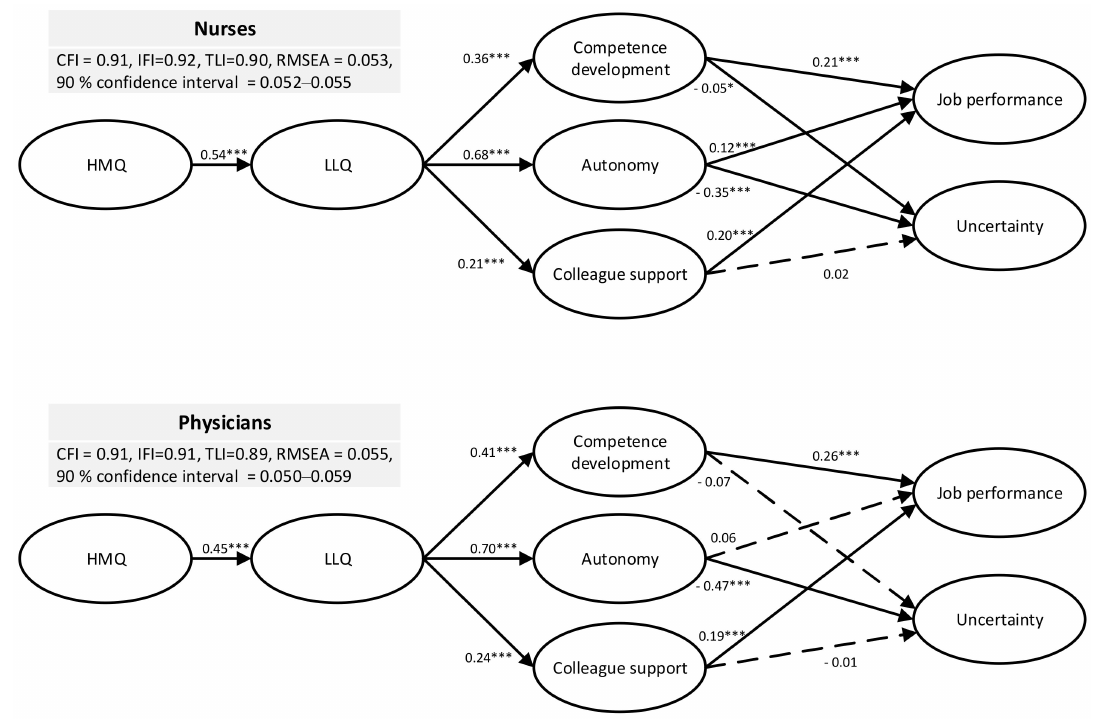
Figure 2. Structural modelling conducted on nurses and physicians. Note: * p < 0.05, *** p < 0.001. HMQ: Hospital management quality; LLQ: Local leadership